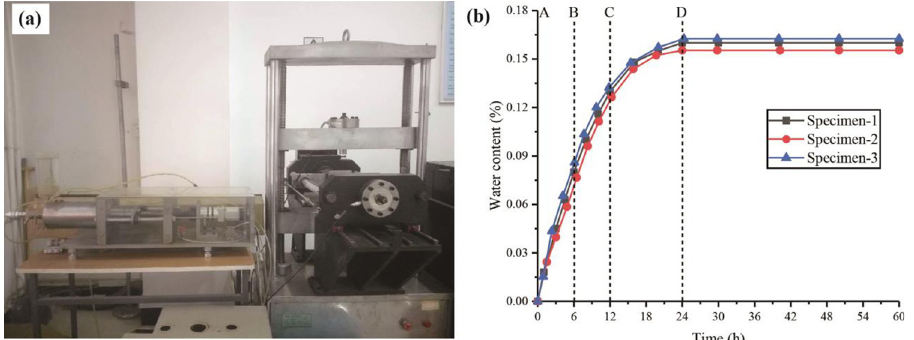
Fig 3. Water content test: (a) immersion device; (b) test